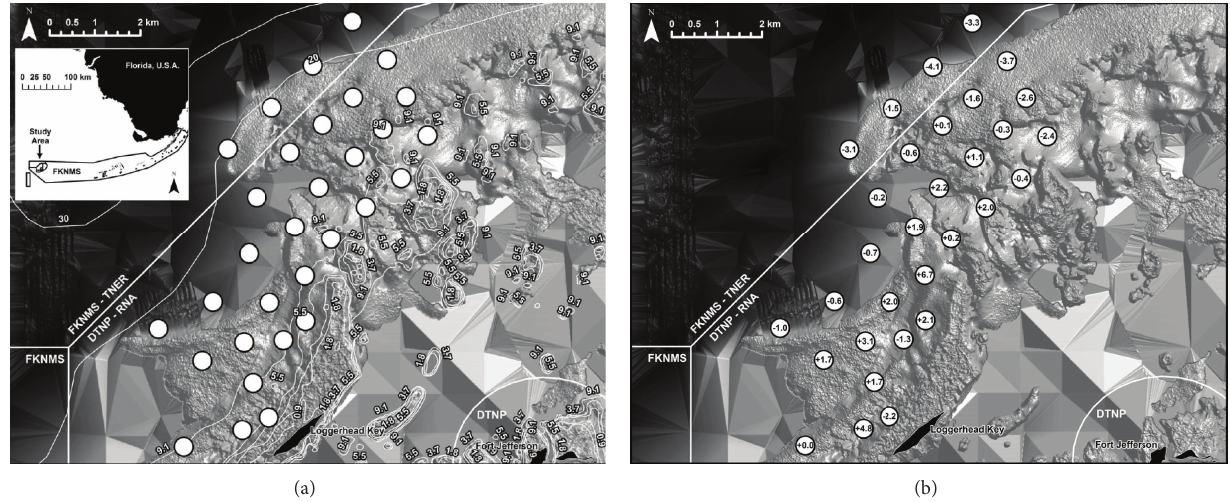
Figure 3: (a) Configuration of acoustic array relative to bathymetry (m) and management boundaries and (b) systematic bias in estimated red grouper home range size attributable to location of individual home range centers. White circles indicate locations of simulated acoustic receivers; numbers within circles indicate percent of under- or overestimation by minimum convex polygon (MCP) home range method for simulated fish with home range center at location of circle. Inset in (a) shows study area relative to state and federal management boundaries. FKNMS: Florida Keys National Marine Sanctuary; DTNP: Dry Tortugas National Park; RNA: Research Natural Area; TNER: Tortugas North Ecological